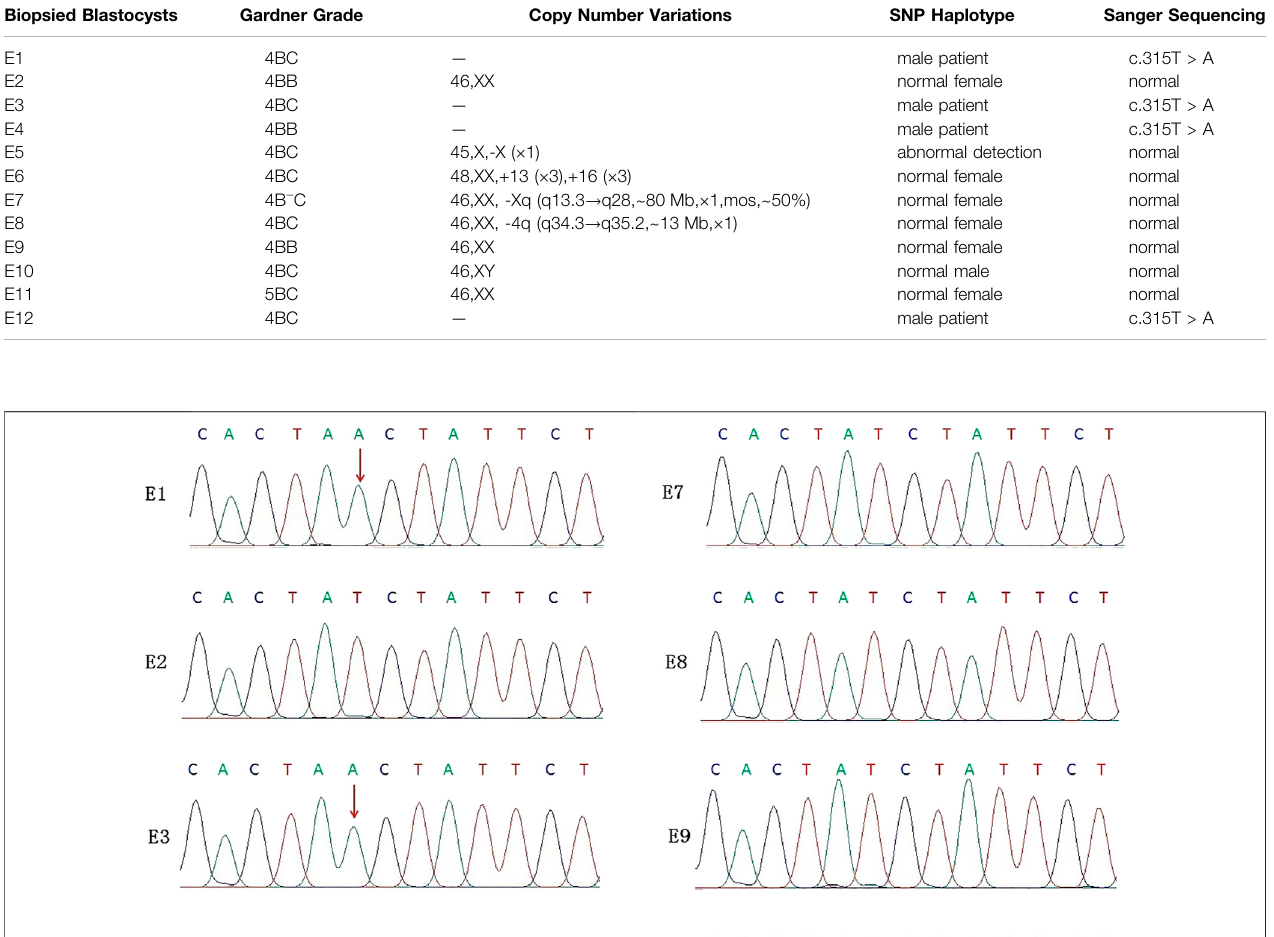
Frontiers in Genetics |